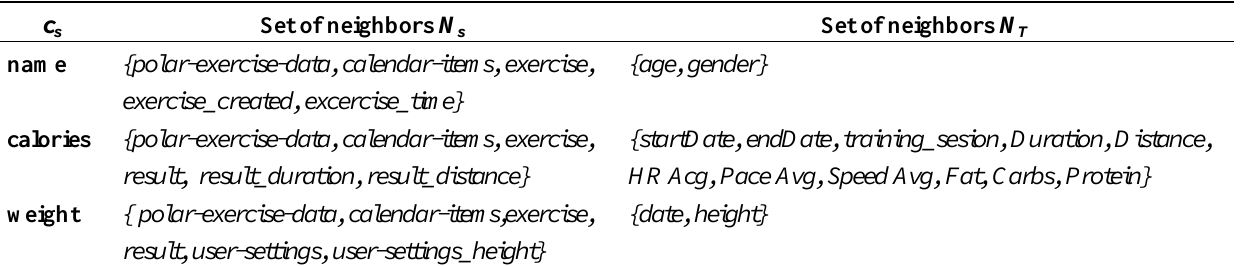
Table 4. Sample of sets of neighbors generated in structure level matching process.